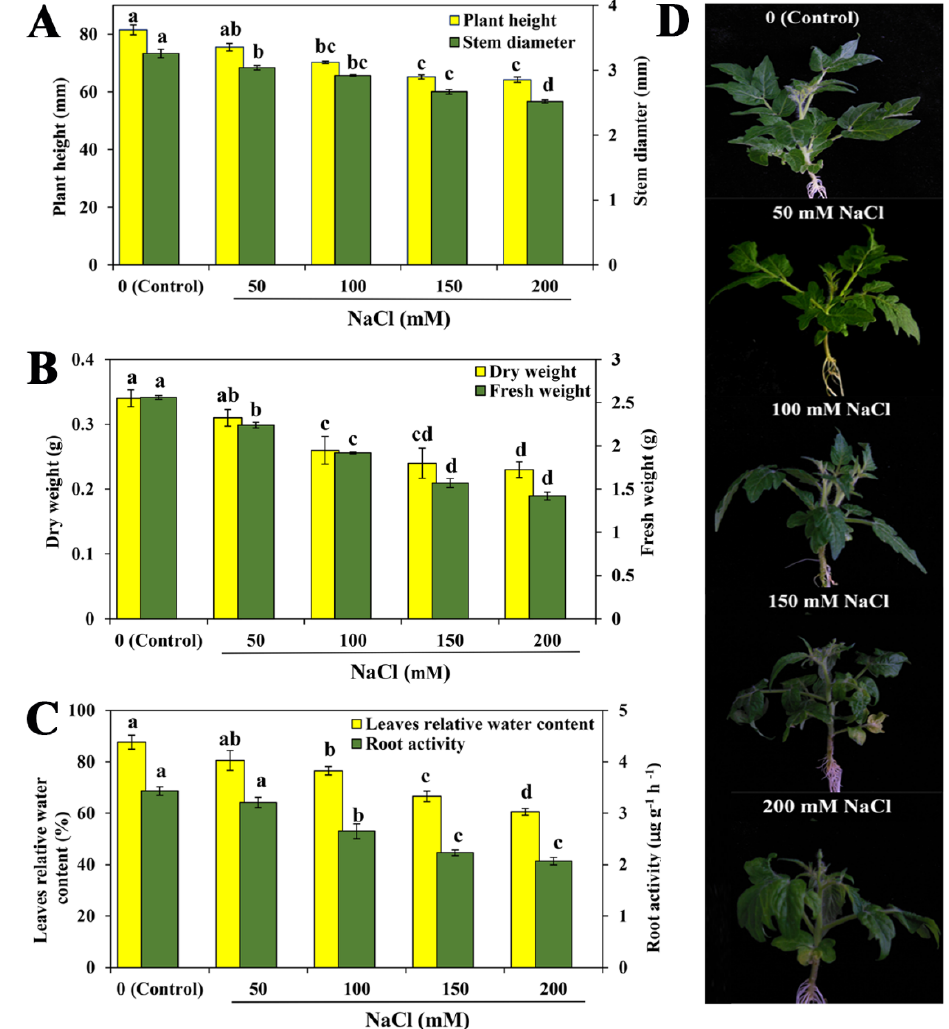
Figure 1. Effects of different concentrations of NaCl on tomato seedling growth. ( A ) Plant height and stem diameter. ( B ) Dry weight and fresh weight. ( C ) Leaf relative water content (LWC) and root activity. Photographs ( D ) were taken after seven days of the treatments indicated. The values (means ± SE) are the averages of three independent experiments ( n = 15). Bars not sharing the same letters indicate statistically significant differences according to Duncan’s multiple range test ( p < 0.05).